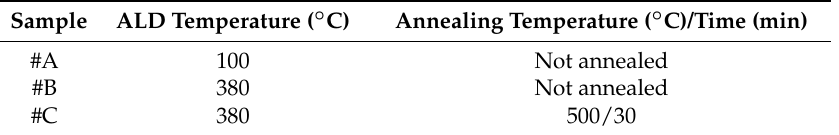
Table 1. Atomic layer deposition (ALD) and annealing temperatures for the studied